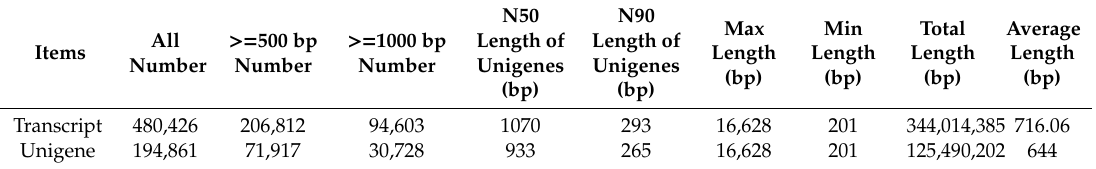
Table 2. Summary of transcriptome sequencing and assembly for Anadara kagoshimensis .